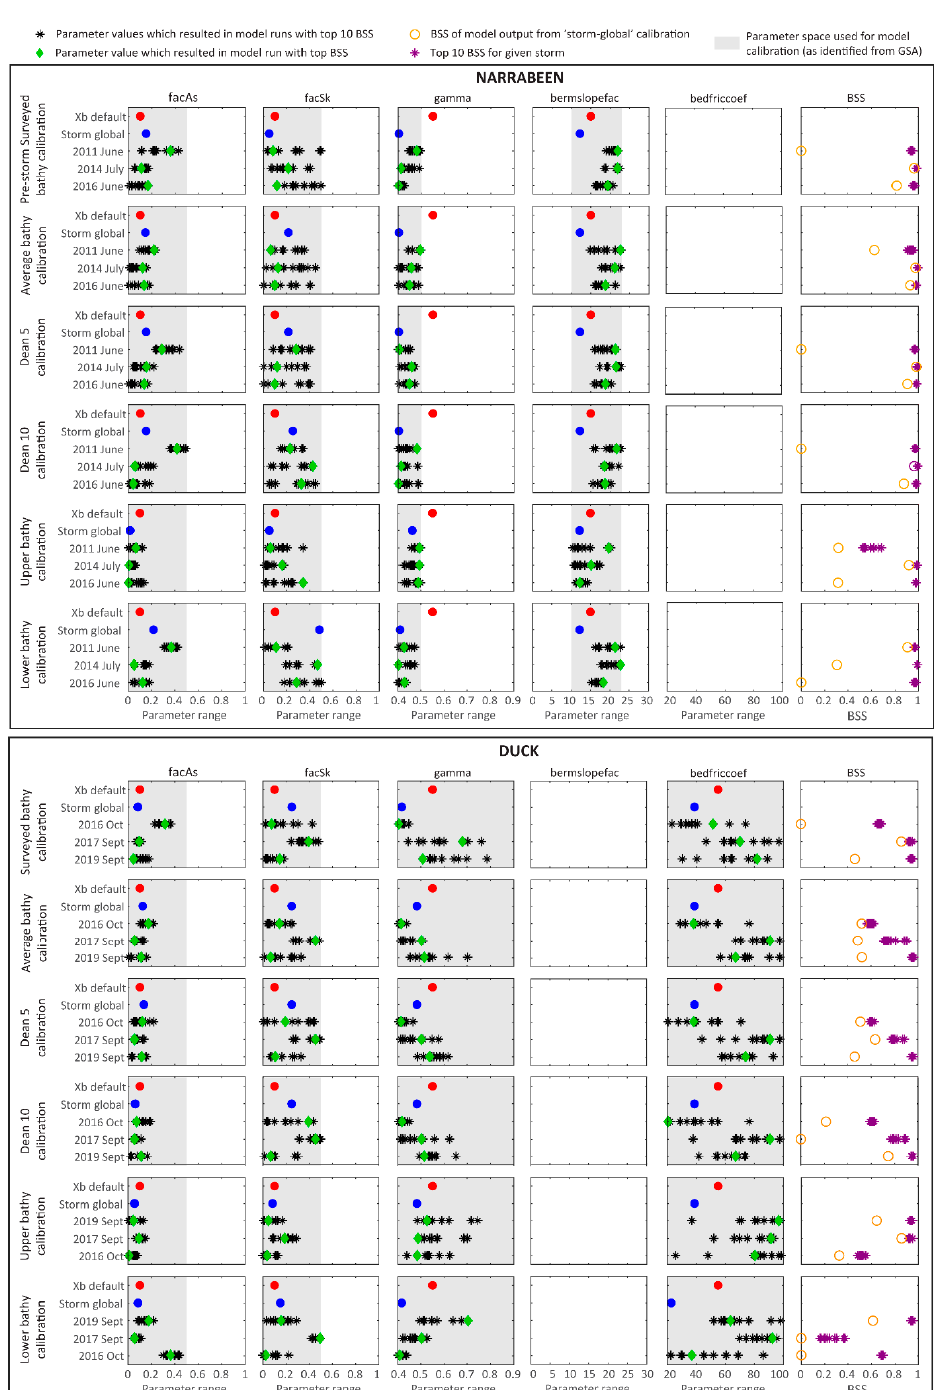
Figure 9. The distribution of model parameter values for individual storms and bathymetry scenarios used in the calibration of XBeach. The four parameters that were optimized at each site are shown in the figure. Note that bedfriccoef ( bermslopefac ) was not used in the calibration of Narrabeen (Duck) and has been left blank. The black points show the spread of the parameters for the top 10 BSS values of a given storm. The associated BSSs are shown on the far-right subplot. The green point for each storm shows the parameter value that resulted in the top BSS for that storm. The hollow orange circle on the BSS subplot is the BSS when the “storm-global” parameter values are used to simulate the given storm event. For these “storm-global” outputs, if the BSSs are less than 0, the value has been shown as 0 in the figure for